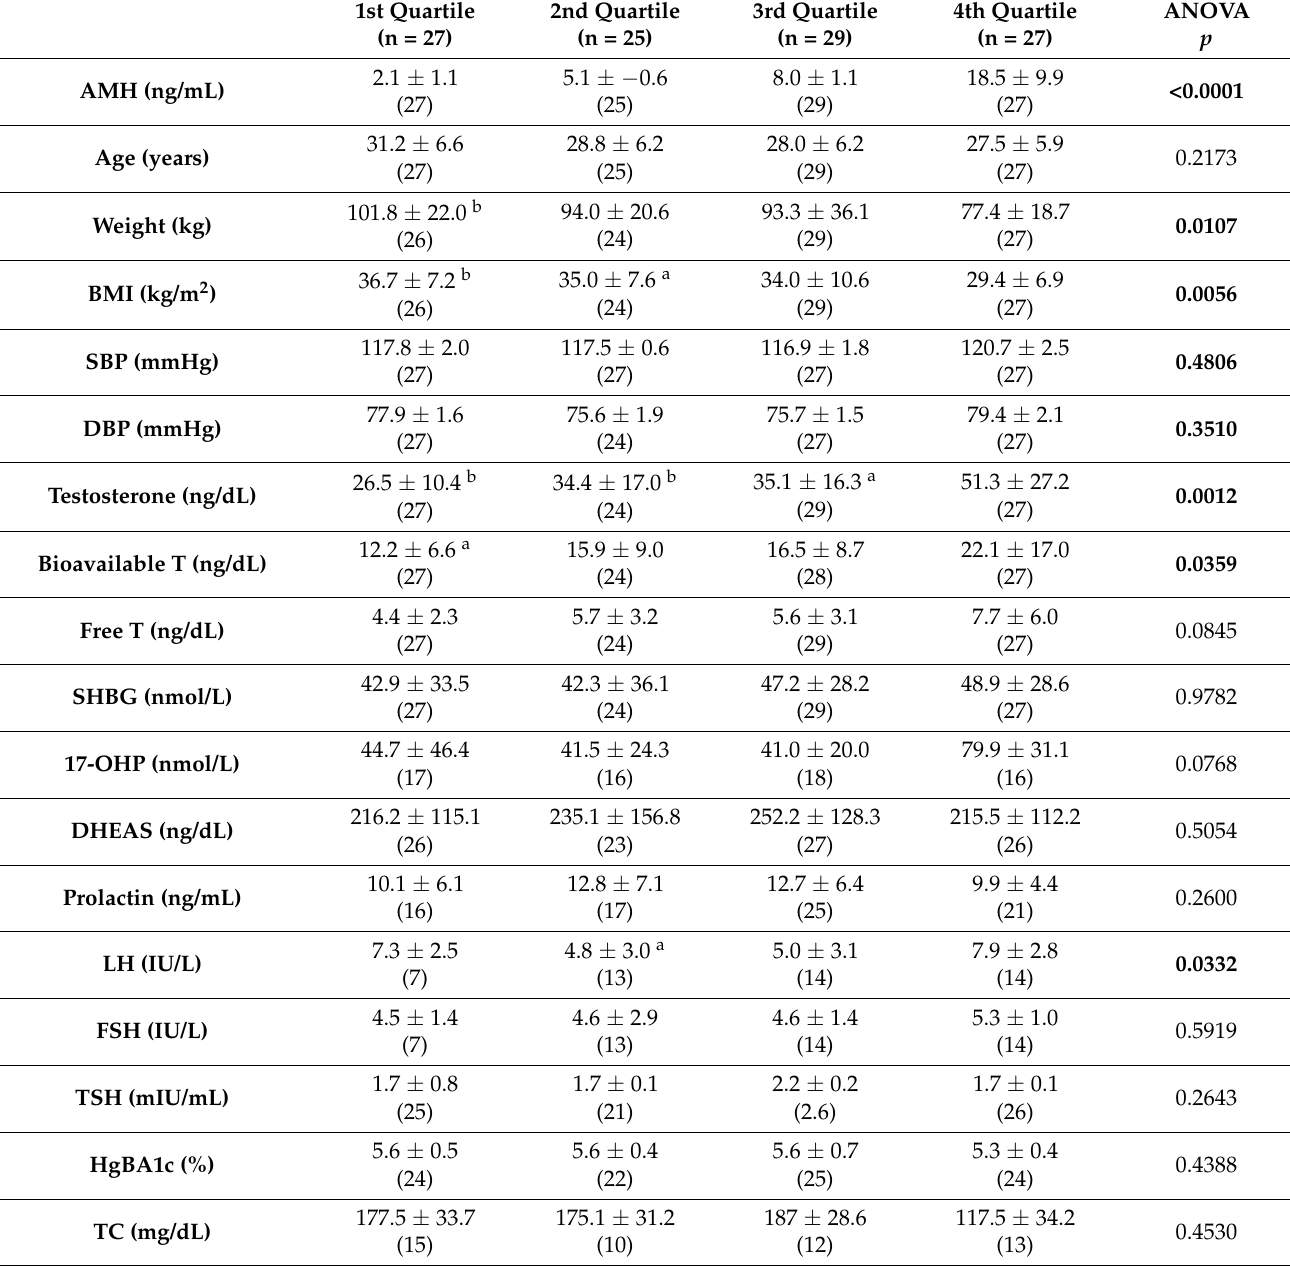
Table 2. Biochemical and clinical characteristics of women with PCOS based on AMH quartiles (means ± STD). The number of data points in each cell is presented in parentheses